Question: What visual encoding does this figure use to show its data?
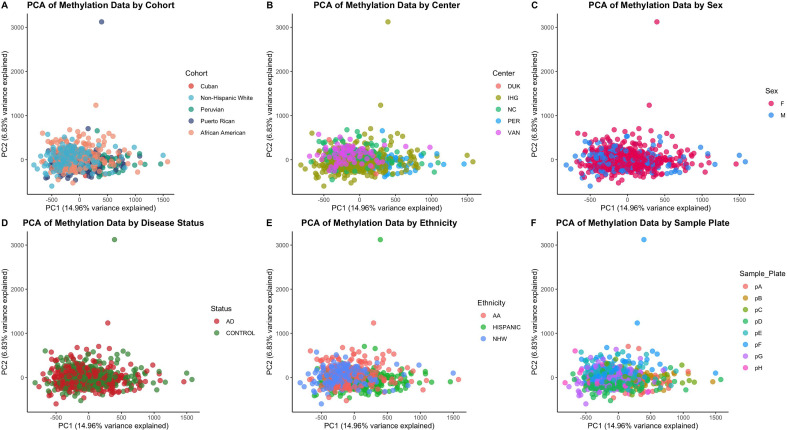
Answer: scatter